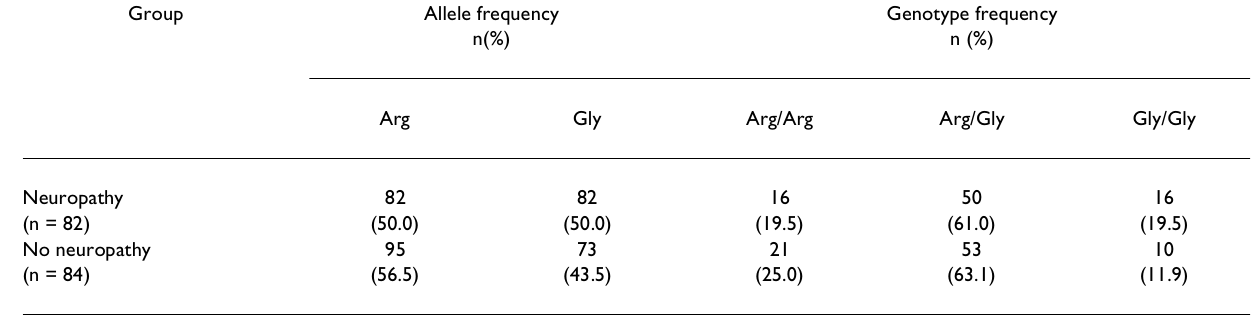
Table 4: Allele and genotype distribution of the Arg213Gly Mn-SOD polymorphic marker in type 1 diabetic patients with and without neuropathy Group